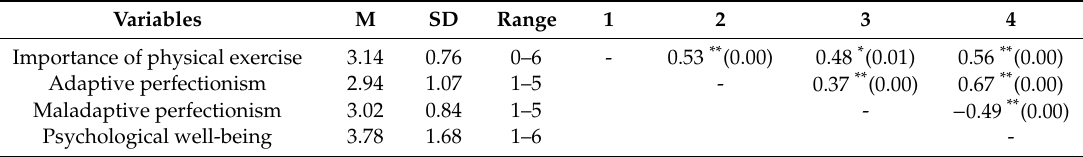
Table 3. Partial correlations between perfectionism and well-being when controlling for the intensity of physical